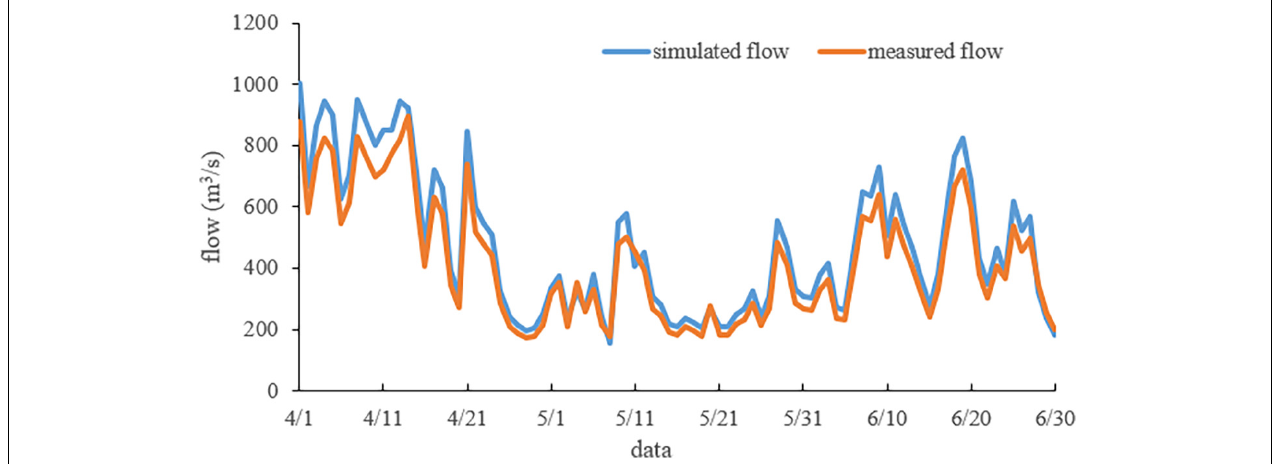
FIGURE 4 | The verification results of the LM section.